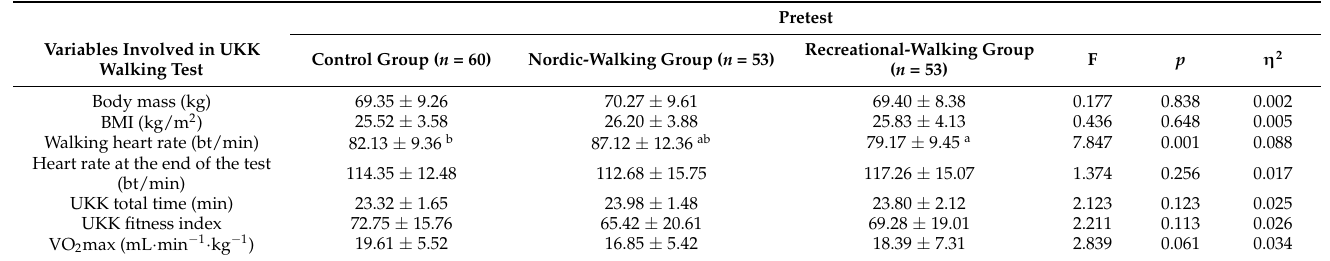
Table 2. ANOVA for anthropometric measurement variables, heart rate, UKK walking test time and fitness index, and VO2max for pretest, with mean values (SD).